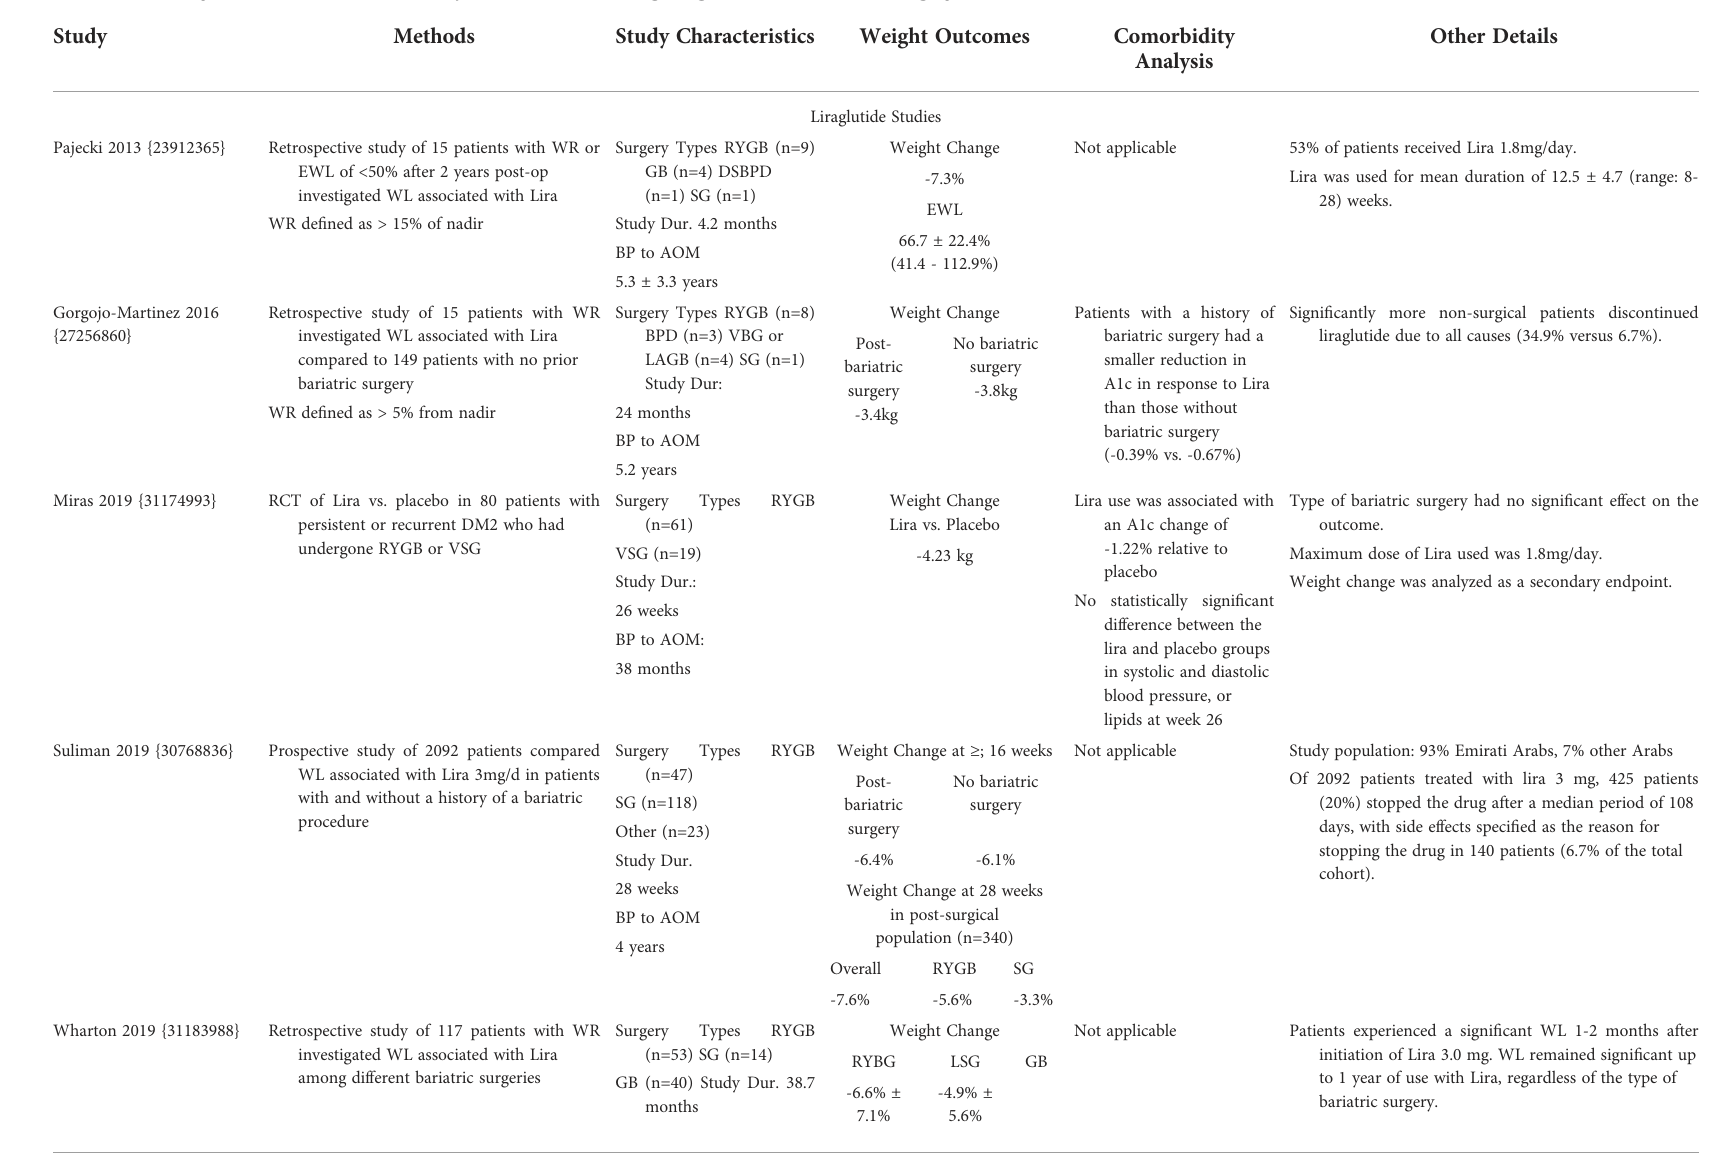
TABLE 1 Summary of Studies on Pharmacotherapies Aimed at Addressing Weight Gain After Bariatric